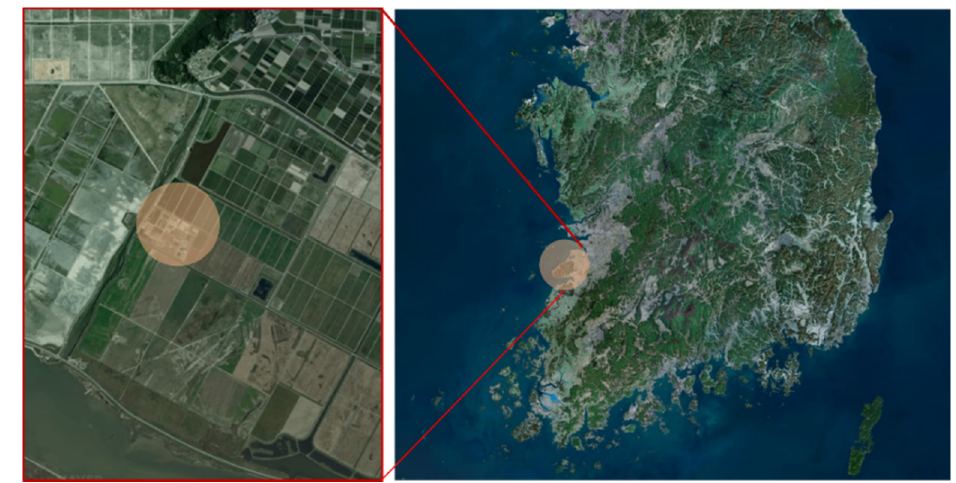
Figure 3. Site of the geotechnical survey and settlement monitoring system construction.